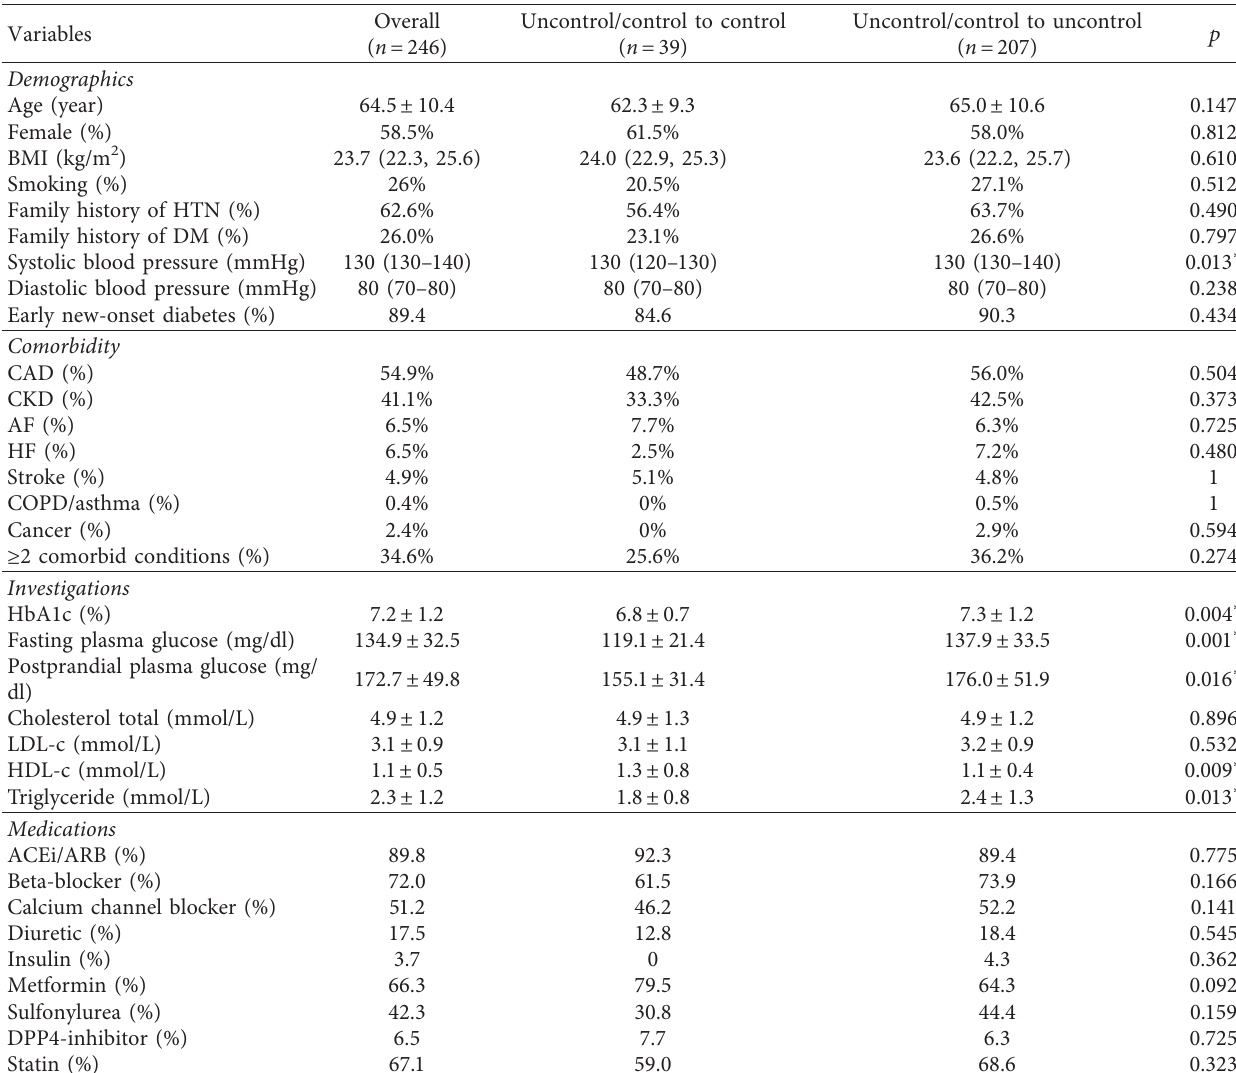
Table 1: Baseline patients’